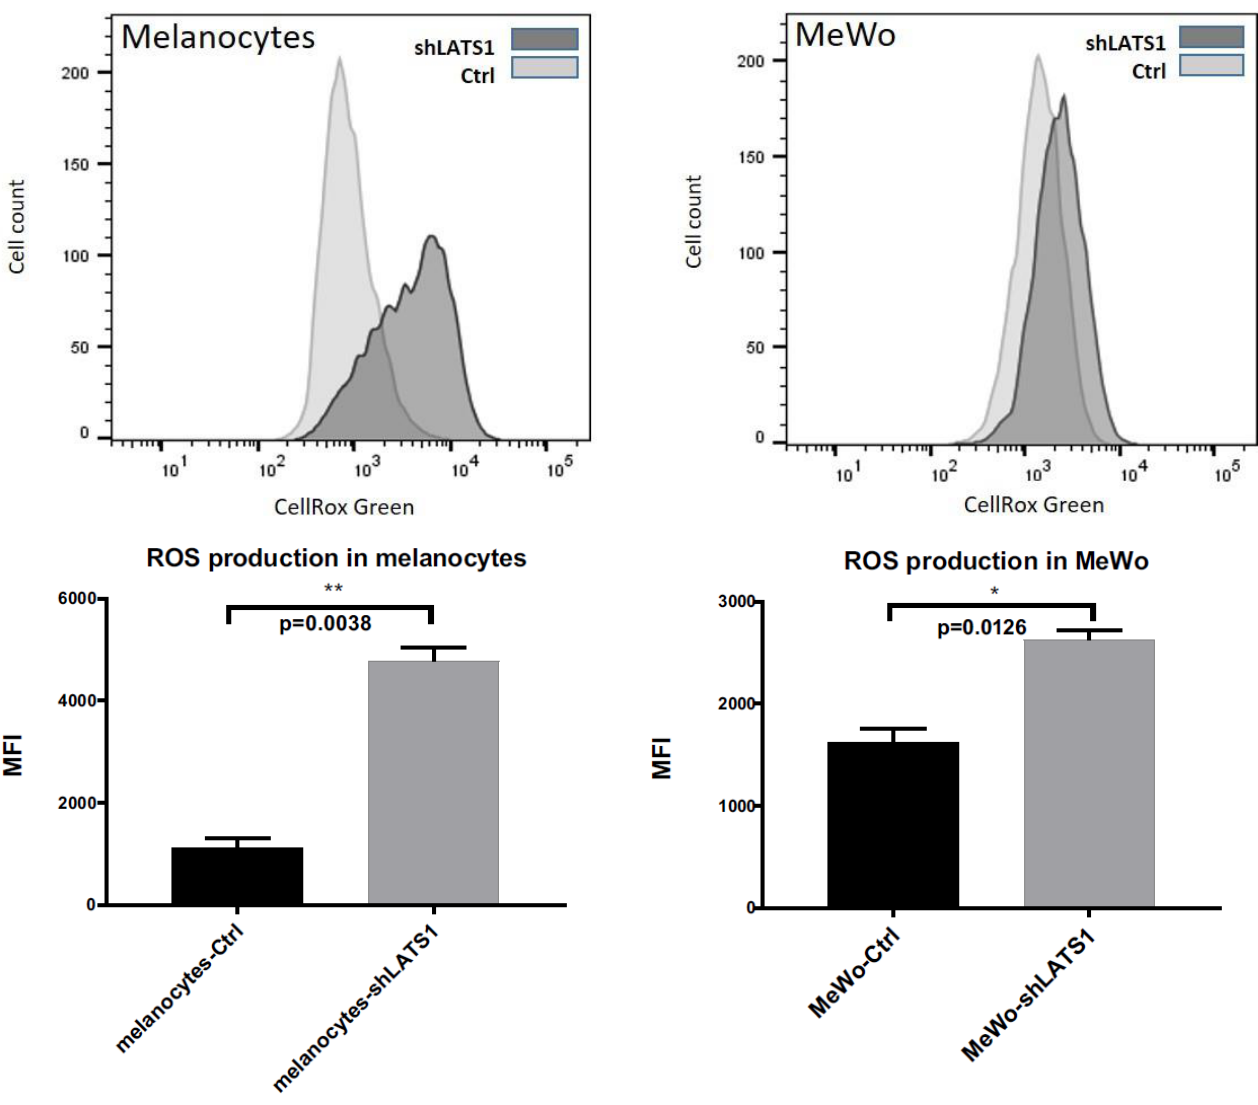
Figure 3. Intracellular ROS levels following LATS1 knockdown. Flow cytometry analyses of the levels of reactive oxygen species (ROS) in primary human melanocytes (left) and MeWo cells (right); CellRox Green regent was used as ROS sensor with green fluorescence enhanced by oxidation; mean fluorescence intensity (MFI) was used as a measure of ROS content inside the cells; * p ≤ 0.05, ** p ≤ 0.01.